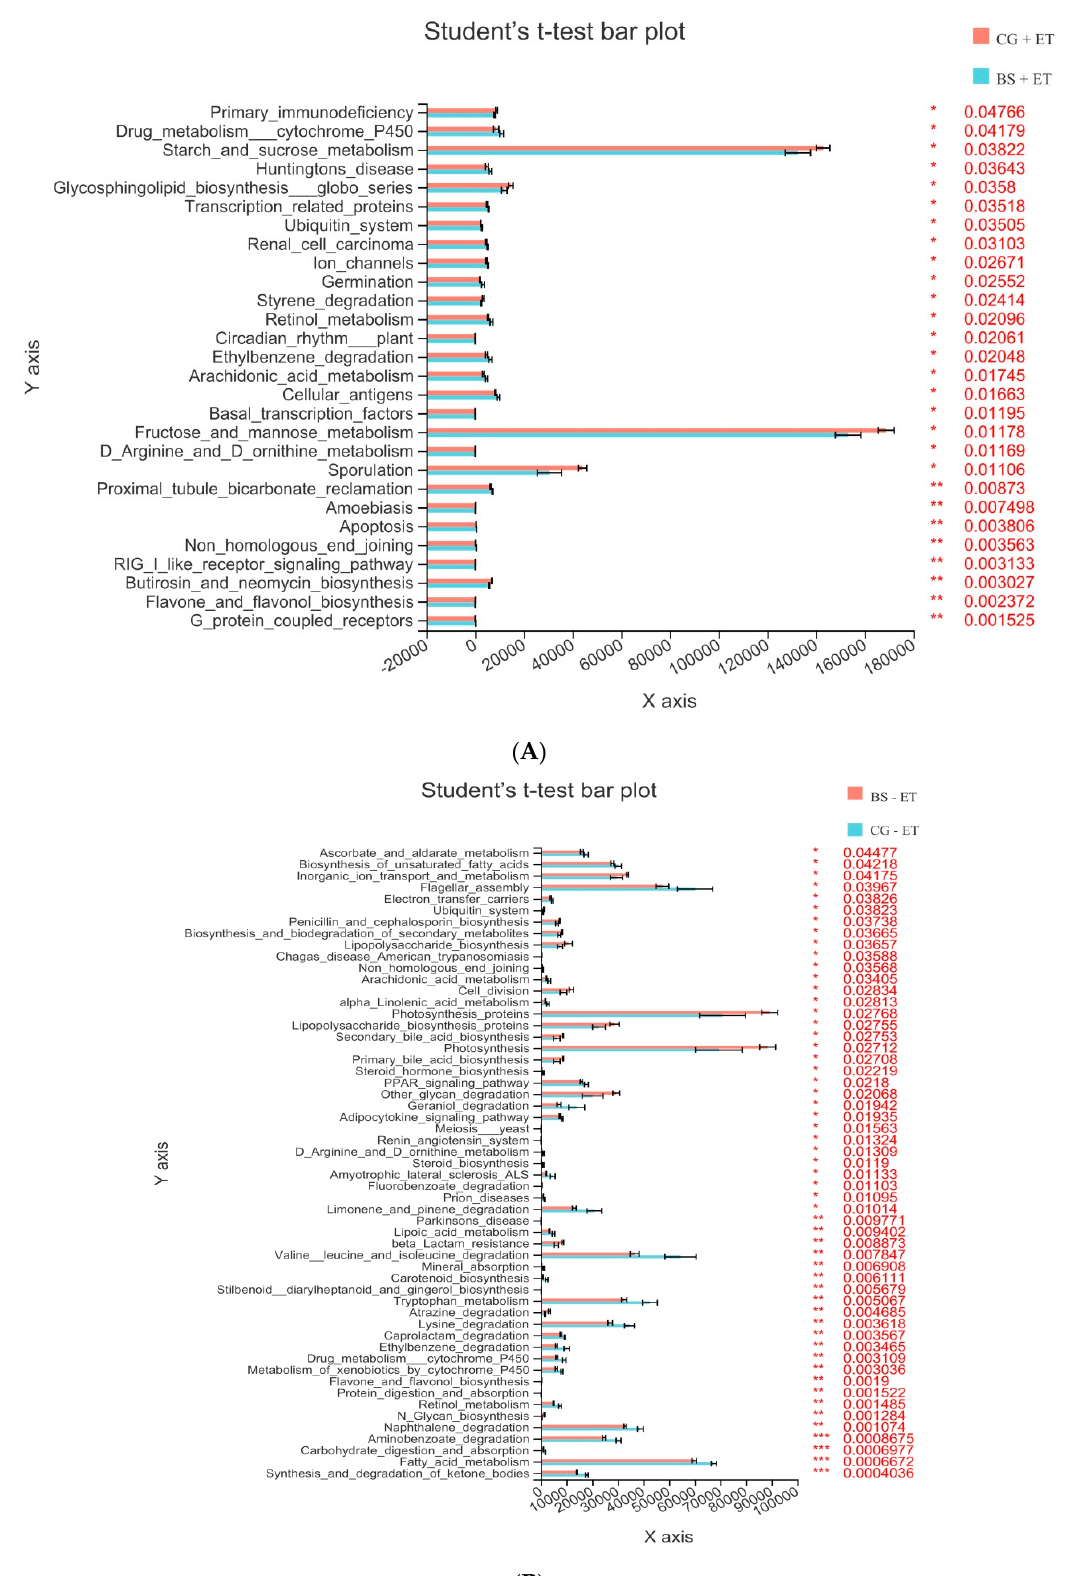
Figure 6. Third-level KEGG pathways affected by probiotic feeding and Eimeria infection. ( A ) Affected KEGG pathways in groups CG + ET versus BS + ET comparison. ( B ) Affected KEGG pathways in groups CG − ET versus BS − ET comparison. *, **, *** represent significant difference.